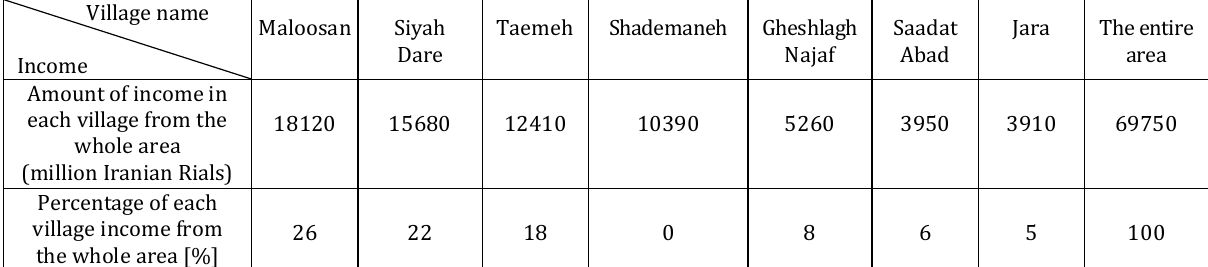
Table 8. Ratio of income in each village in the study